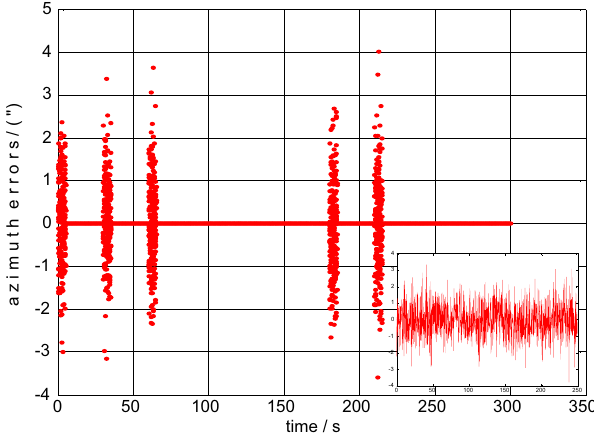
Figure 6. The static azimuth errors of group 1.